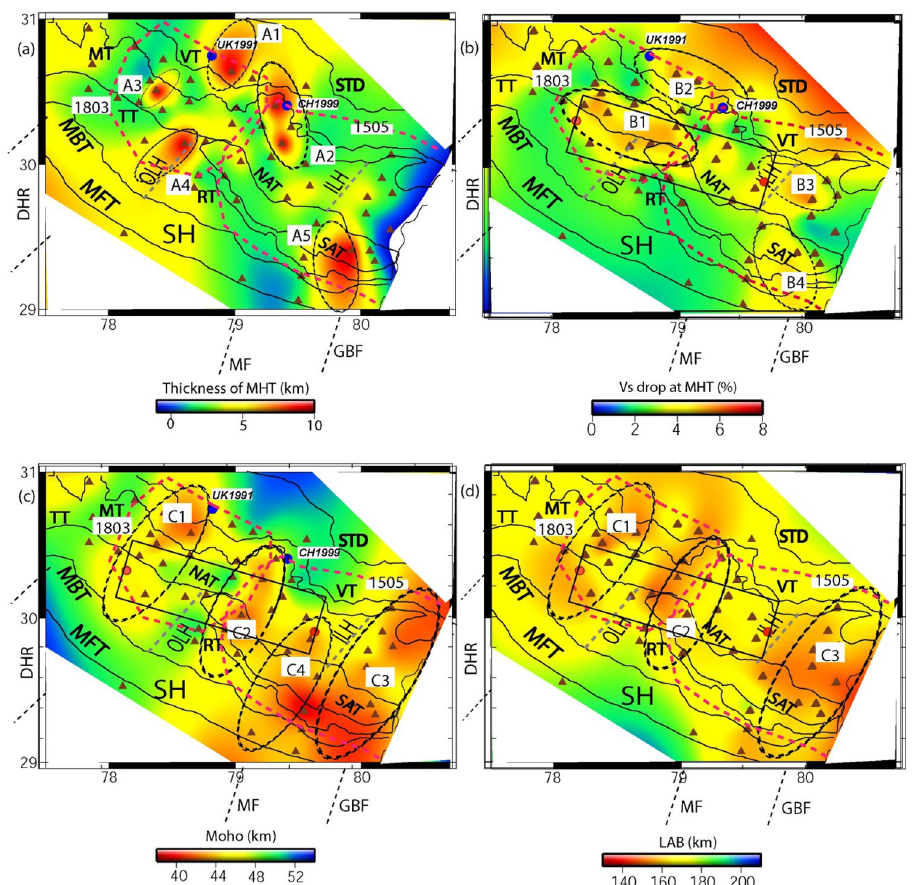
Figure 5. Contour plots of modelled ( a ) MHT thickness (in km), ( b ) Drop in V s at the MHT (in %), ( c ) Moho depths (in km) and ( d ) lithospheric thickness (in km), through the joint inversion of PRFs and surface wave dispersion data, with major geological formations in the Singhbhum Craton. The locations of the 1991 Uttarkashi (M w 6.6) and 1999 Chamoli (M w 6.4) earthquakes are shown by large filled blue circles in Fig. 5( a – c ). DHR marks the inferred NE extension of the Delhi-Haridwar basement ridge while MF represents a NE striking inferred Moradabad fault 23 . And, GBF marks the NE extension of the Great Boundary Fault separating the ADFB from the VB further south (Fig. 1). Black dotted elliptical zones (A 1 , A 2 , A 3 , and A 4 ) in Fig. 5( a ) represent zones of large MHT thicknesses while they (B 1 , B 2 , B 3 , and B 4 ) mark the zones of Versus drop at MHT in Fig. 5( b ). But, black dotted elliptical zones (C 1 , C 2 , C 3 , C 4 ) mark the mapped NE trending crustal transverse features as shown in Fig. 5( c ) while they (C 1 , C 2 , and C 3 ) represent mapped NE trending lithospheric transverse features as shown in Fig. 5( d ). The inferred rupture zones of the 1803 and 1505 paleo earthquakes are marked by dotted pink lines (after Bilham (2019). Major thrusts (shown by black lines): VT: Vaikrita Thrust; MT: Munsiari Thrust; TT: Ton Thrust; RT: Ramgarh Thrust; NAT: North Almora Thrust; SAT: South Almora Thrust; MBT: Main Boundary Thrust; MFT: Main Frontal Thrust. SH marks the Siwalik Himalaya. ILH marks the inner lesser Himalaya while OLH marks the outer lesser Himalaya. A black rectangular area in Fig. 5( b – d ) represents the location of the conductor as inferred by numerical modelling of the magnetometer array data of the UK Himalaya 53